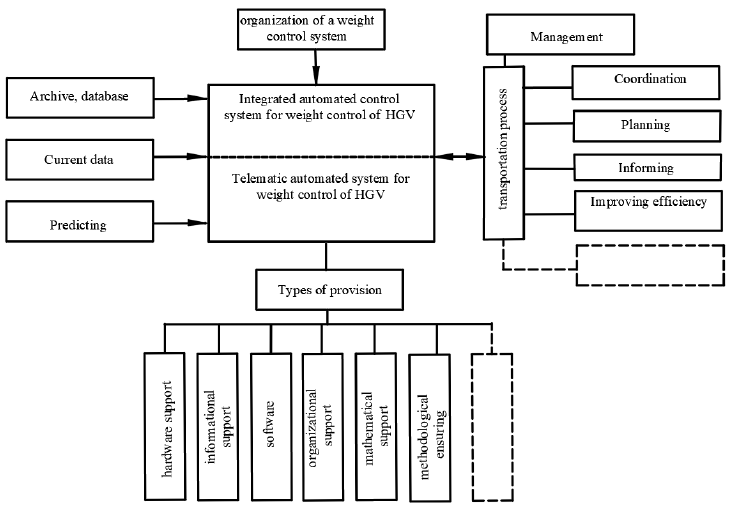
Figure 1. Model of an integrated telematic automated control system of weight control of HGVs on the road (TASWC HGV).